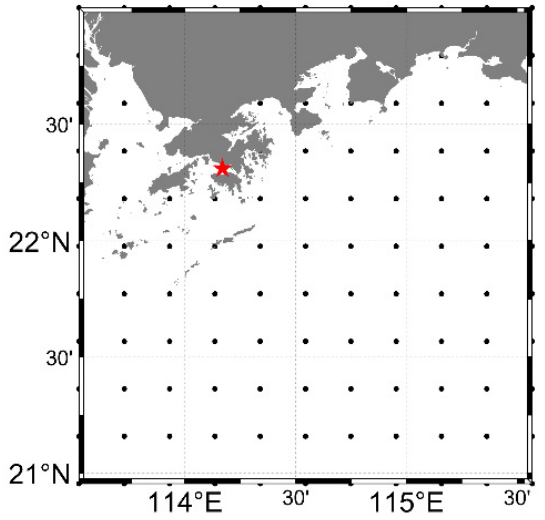
Figure 2. The location of the radiosonde sounding station.